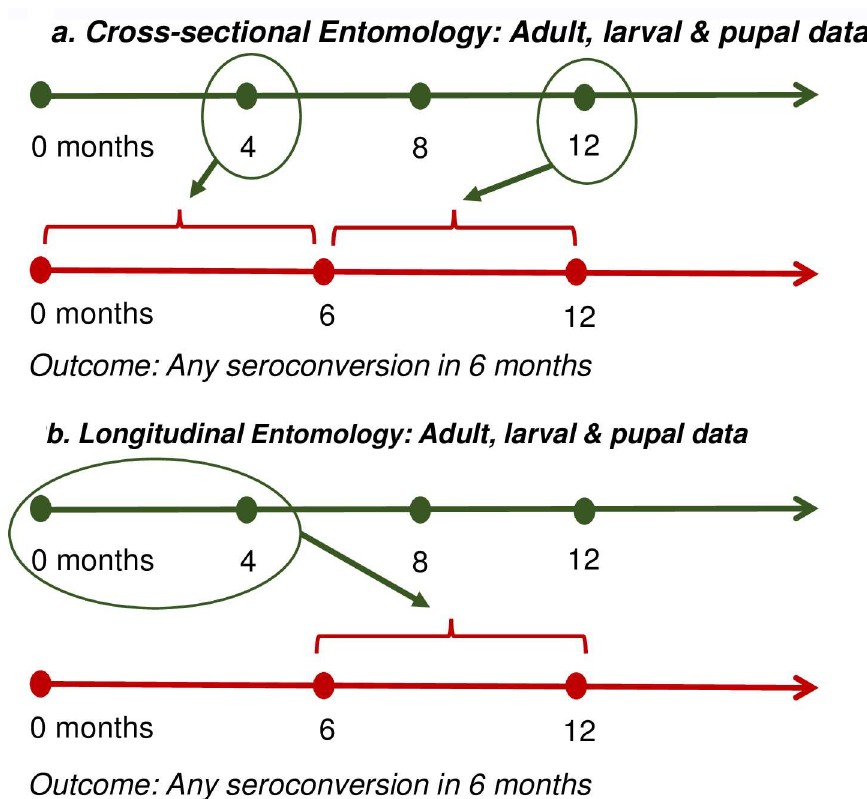
Fig 2. Calculation of cross-sectional and longitudinal measuresof vector abundance. Fig 2a (top) illustrates how cross-sectional measures of vector density were assignedto a six-month pairedserological sample.In Figure 2b (bottom), longitudinal measuresof vector density werecalculatedby taking an average of indicescalculated from survey observations in the periodup to 12 months precedingthe seroconversion interval. Captions for panel in Figure 2a. The entomological measurement taken withinthe seroconversion interval(and nearest the end of the interval, if there was more than one), was usedin the regression analysisas the entomologicalindicatorvariable. Other approaches to linkinga single entomological survey observation with serologicaldata are presented in the SI. The risk ratios estimate the effect of the mosquitoindicatoron the 6-monthrisk of DENV infection. Since inapparent was measuredusingpairedsampleserology,this outcome is inherently intervalcensored. Caption for panel in Figure 2b. Entomological indicescollectedup to 12 months beforethe start of the seroconversion intervalwere averagedand usedin the regression analysisas the entomological indicator variable,matchedto a single6-month